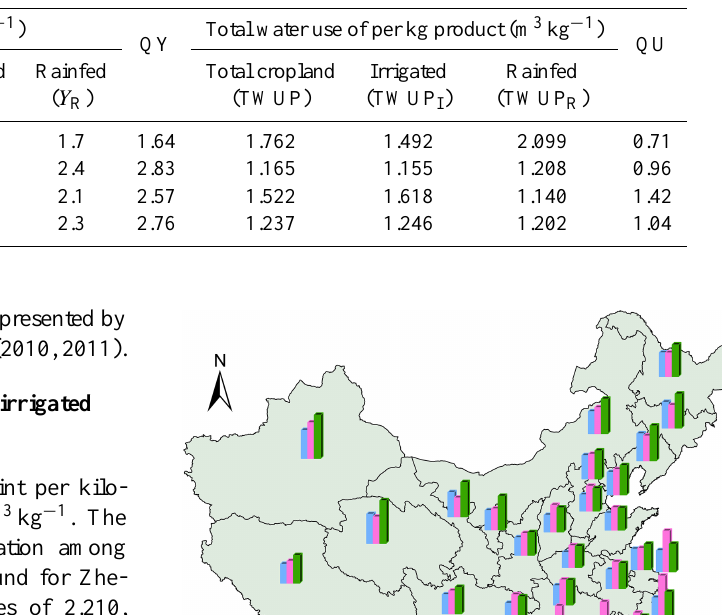
Total water use of per kg product (m 3 kg − 1 ) QY